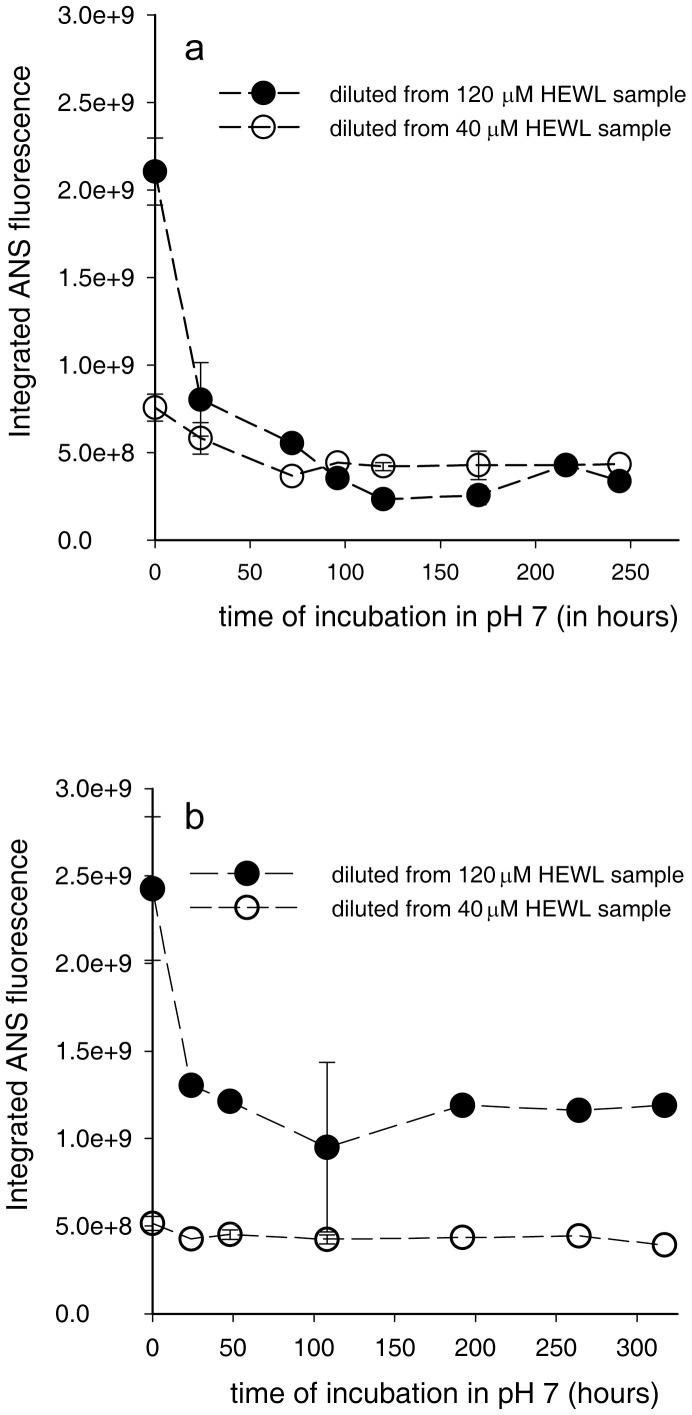
Binding of ANS to HEWL aggregates at equal concentration.Changes in total ANS fluorescence intensity with time after dilution of 144 (a) and 264 hours (b) incubated 120 µM (filled circles) and 40 µM (unfilled circles) HEWL samples in pH 12.2 into 100 mM sodium phosphate buffer at pH 7 are shown. To facilitate comparison, HEWL concentration interacting with ANS in cuvette was maintained constant at 4 µM in both (a) and (b). Error bars, SD; N  =  2.